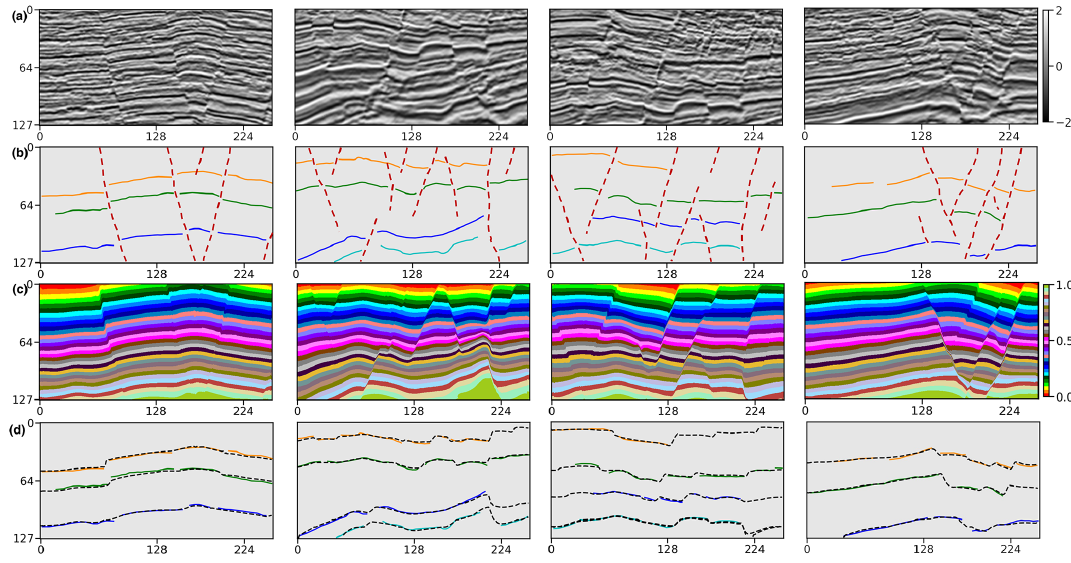
Figure 9. Application in a 2-D seismic field dataset. We display seismic images (a) , input structural data (b) interpreted from the seismic images, predicted structural models (c) , and horizon fitting results (d) ,